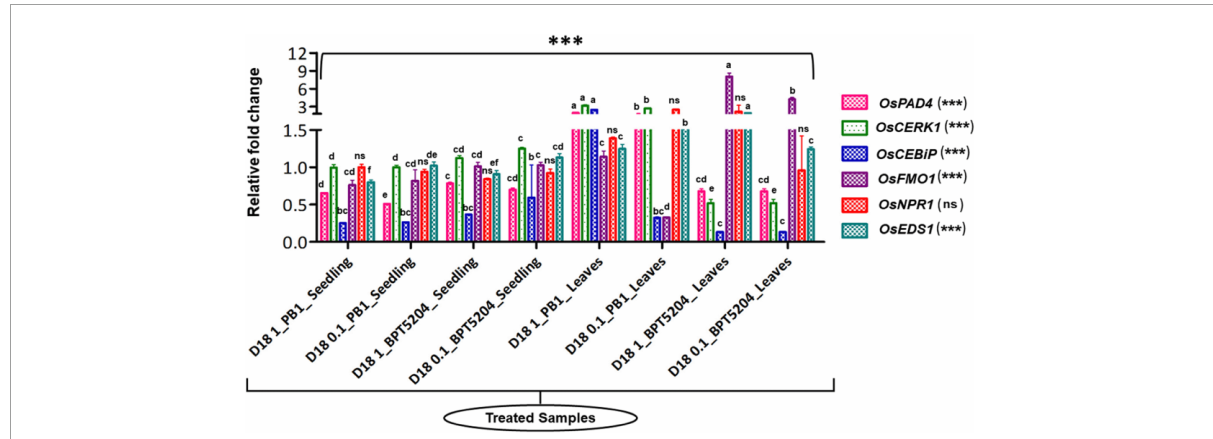
FIGURE6 Transcriptional response of defense genes in rice upon bacterization by M. testaceum . qPCR-based transcriptional analysis of defense gene expression in rice seedlings upon endobacterization. The fold change values obtained for the defense genes were imported into the GraphPad Prism program (https://www.graphpad.com/scientific-software/prism), and two-way ANOVA was conducted using Bonferroni post-hoc test for determining the statistical significance at ∗ p > 0.05, ∗∗ p ≤ 0.001, and ∗∗∗ p ≤ 0.0001. Refer to Supplementary Table 7 for data pertaining to fold changes in gene expression. Different letters represent the different significant groups, based on completely randomized group test done using p